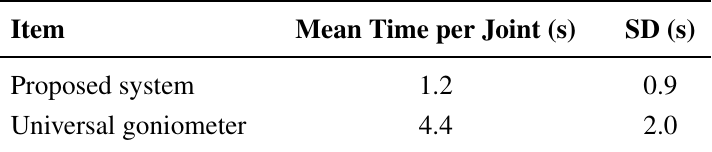
Table 5. Average time of measurement per